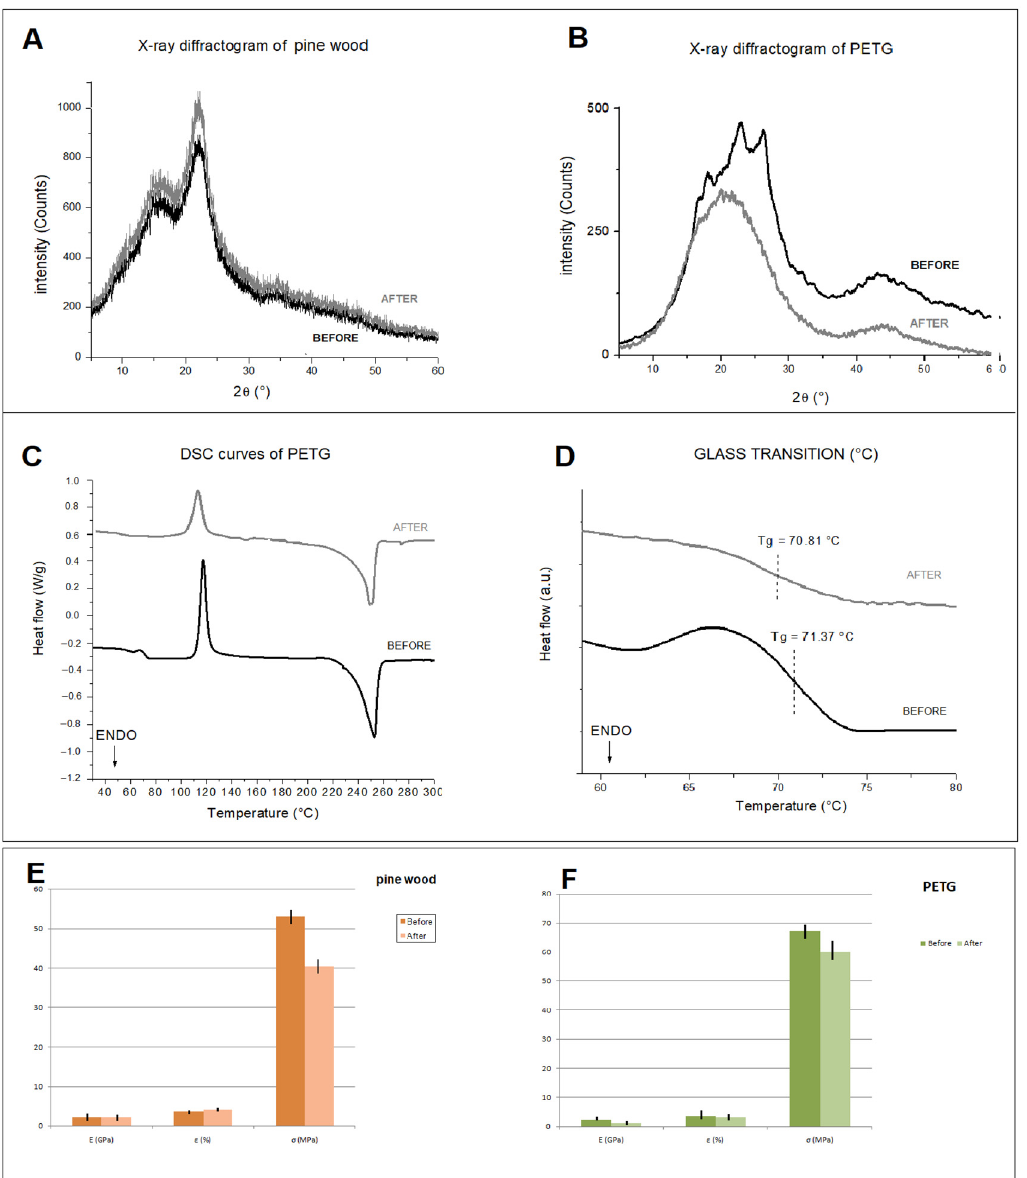
Figure 5. X-ray diffractogram of pine wood ( A ) and PETG ( B ) before and after aging; DSC curves of PETG ( C ) and glass transition temperature ( D ) before and after aging; flexural properties of pine wood ( E ) and PETG ( F ) before and after aging.